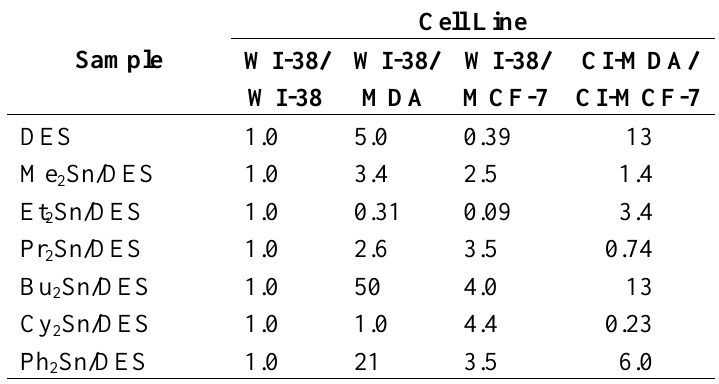
Table 6. Chemotherapeutic Index-50% for the organotin polyethers derived from diethylstilbestrol (DES) and dienestrol for MDA and MCF-7 cell